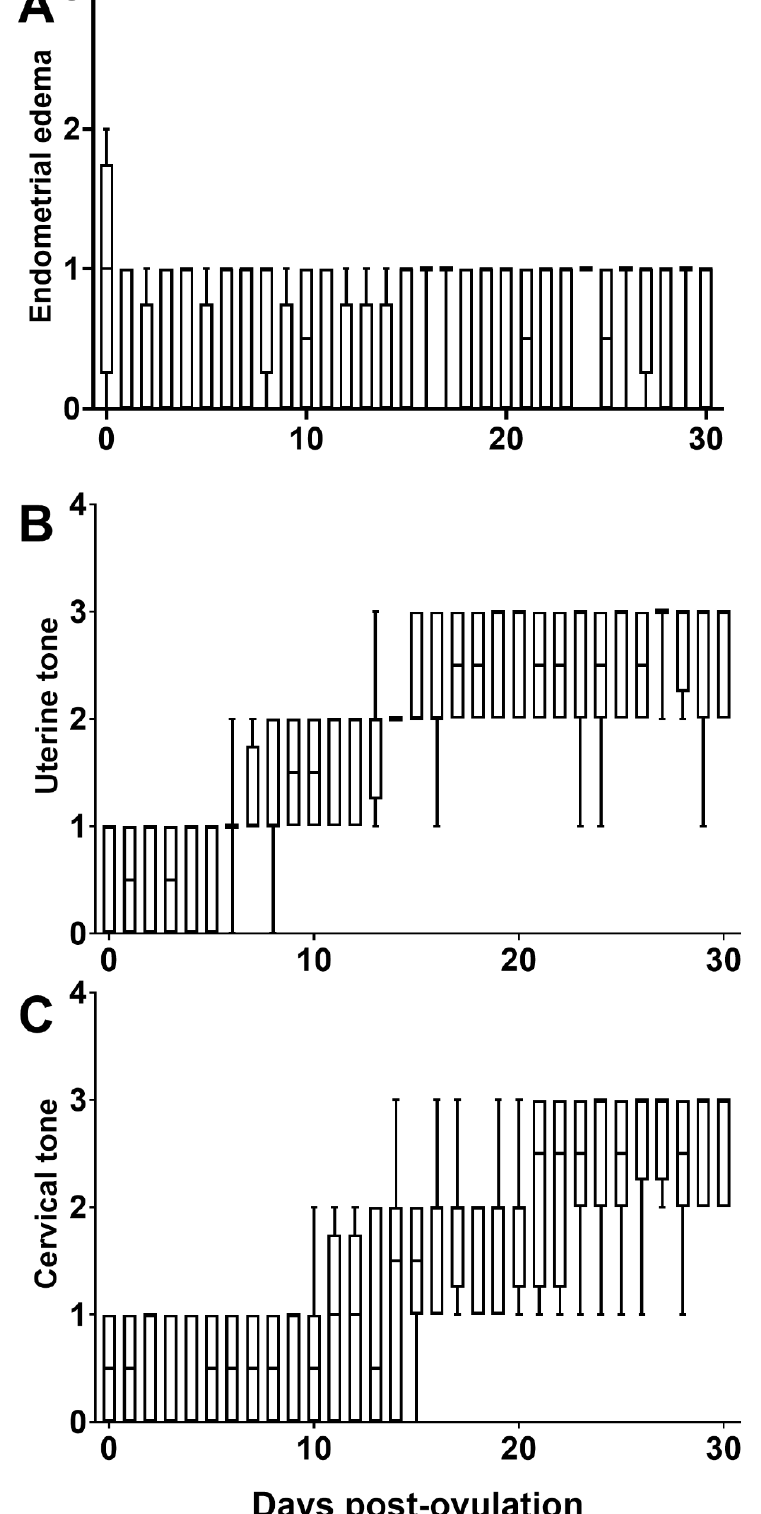
Figure 4. Box plot of the endometrial edema ( A ), uterine ( B ), and cervical tone ( C ) scores in the first 30 days of pregnancy in Caribbean jennies ( n = 8). Day 0, day of ovulation. Endometrial edema: 0, no edema; 1, mild edema; 2, moderate edema; 3, evident edema; 4, exacerbated edema. Uterine and cervical tone: 0, flaccid and 3, turgid.